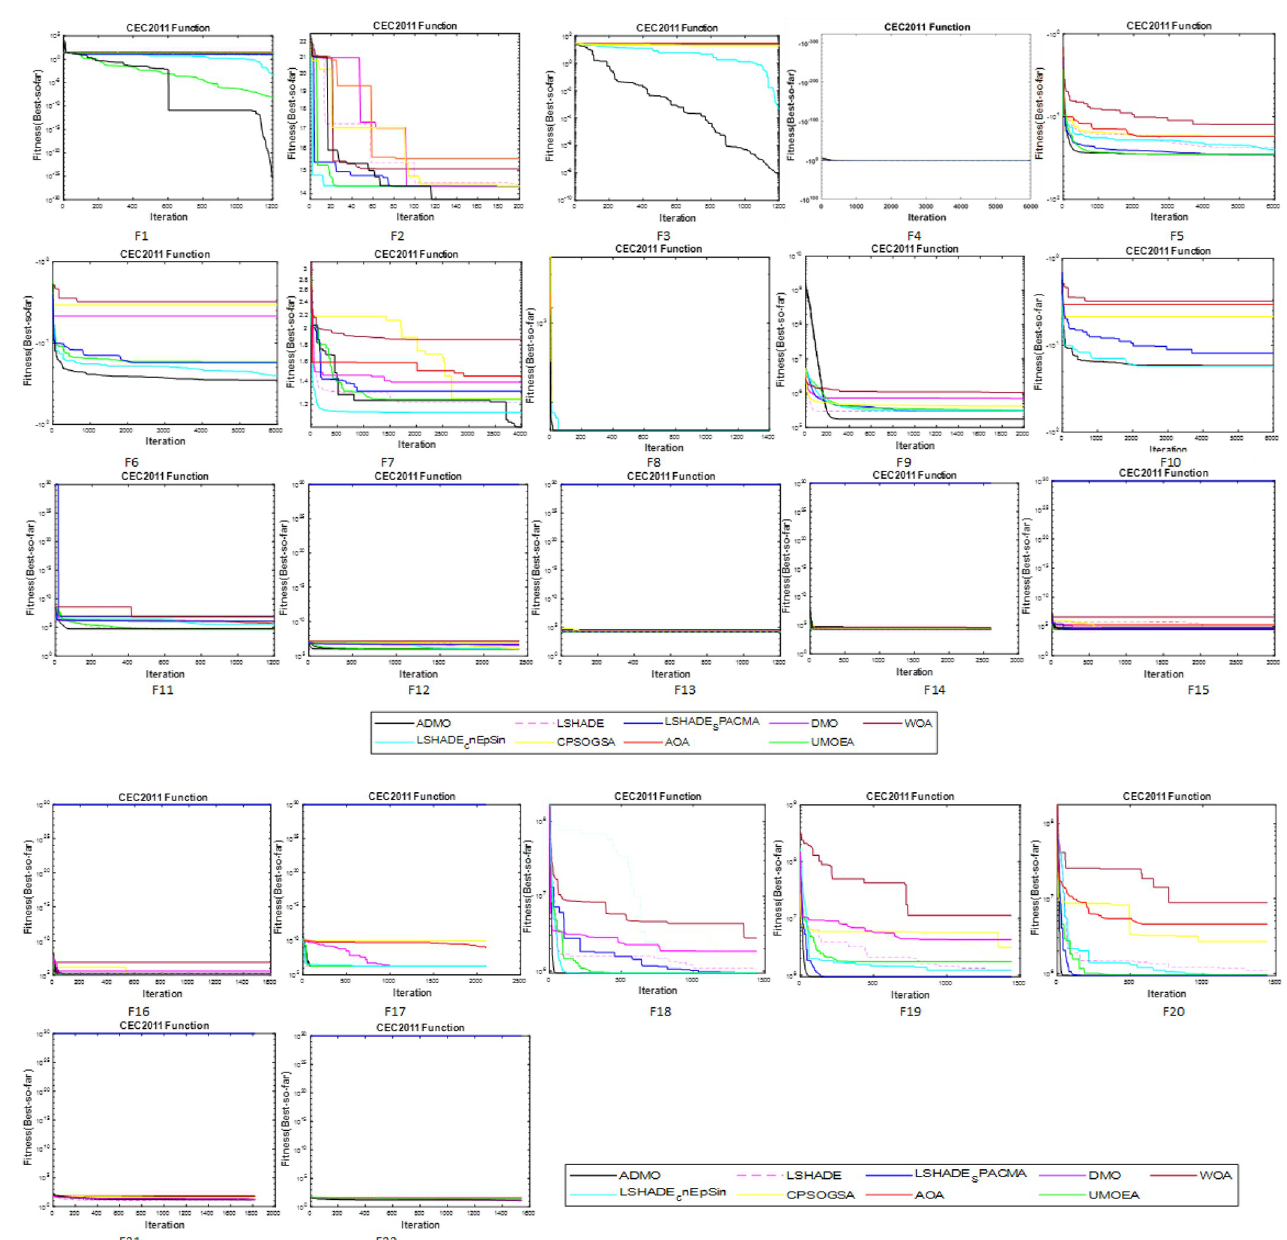
Fig 8. Convergence behavior for CEC 2011 real-world